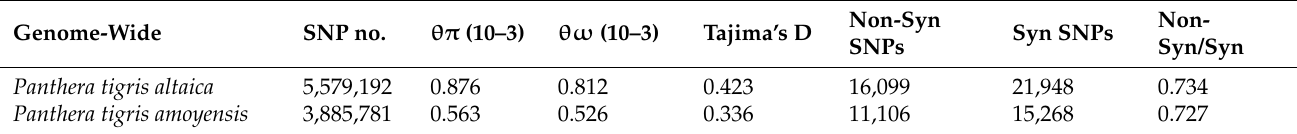
Table 1. Summary SNP statistics in Panthera tigris genotypes.